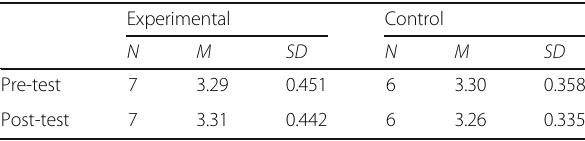
Table 2 Pre- and post-test scores x